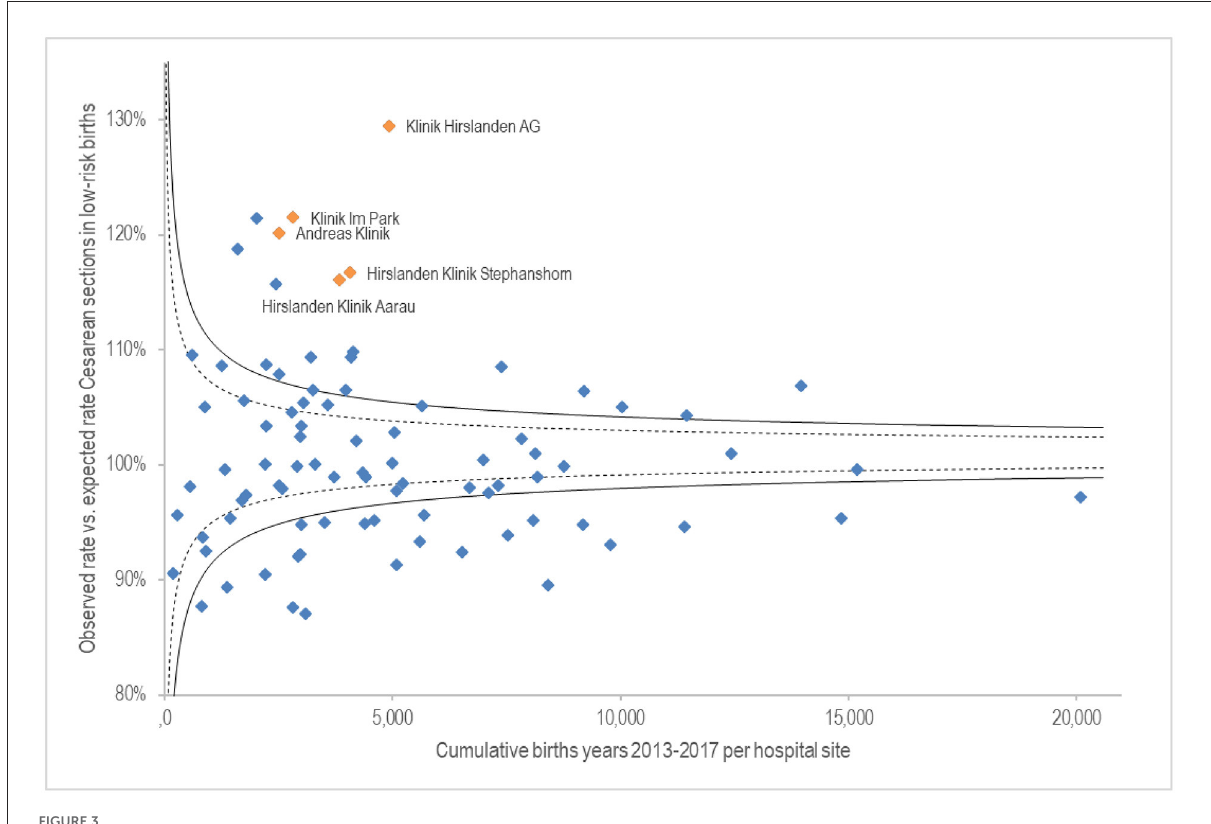
FIGURE3 G.1.5.P Proportion of Caesarean section in low-risk